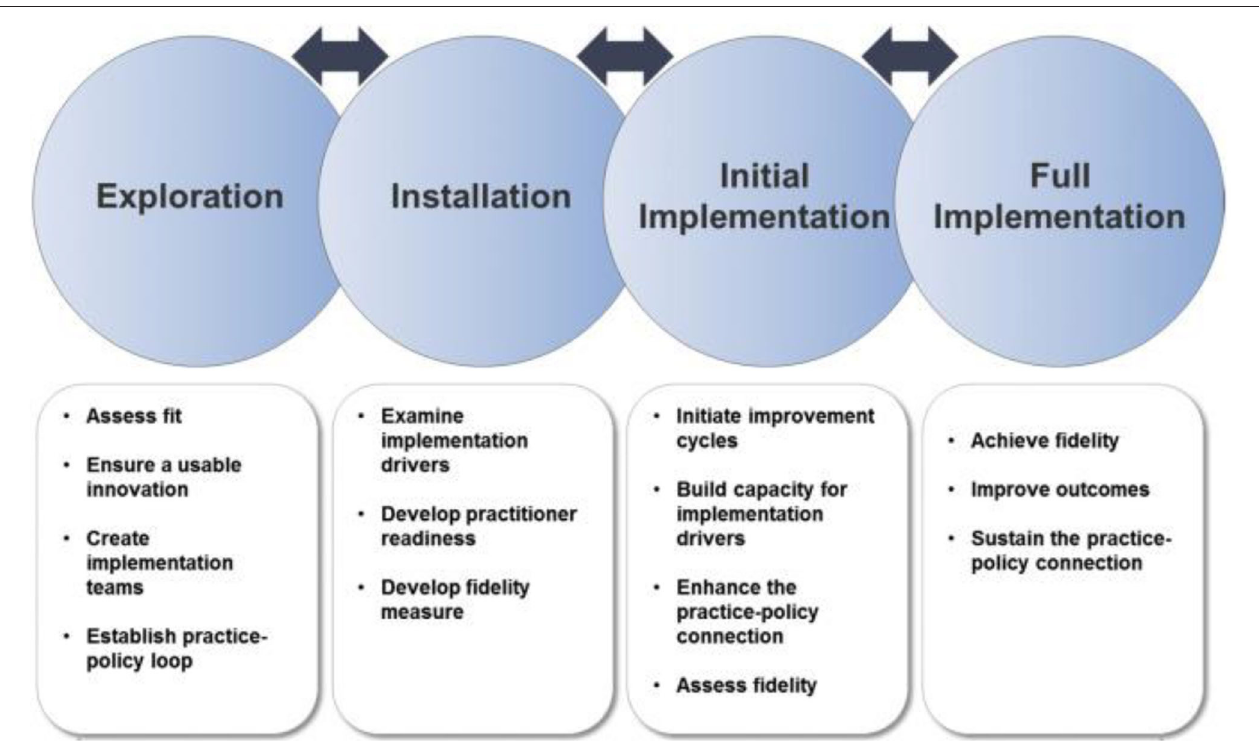
FIGURE 1 | Implementation stages